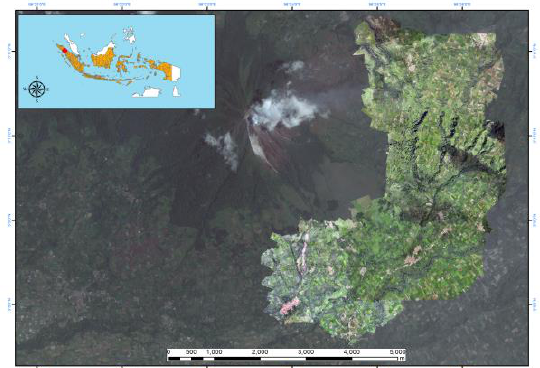
Figure 2. Area of Interest (Mount Sinabung, Indonesia)